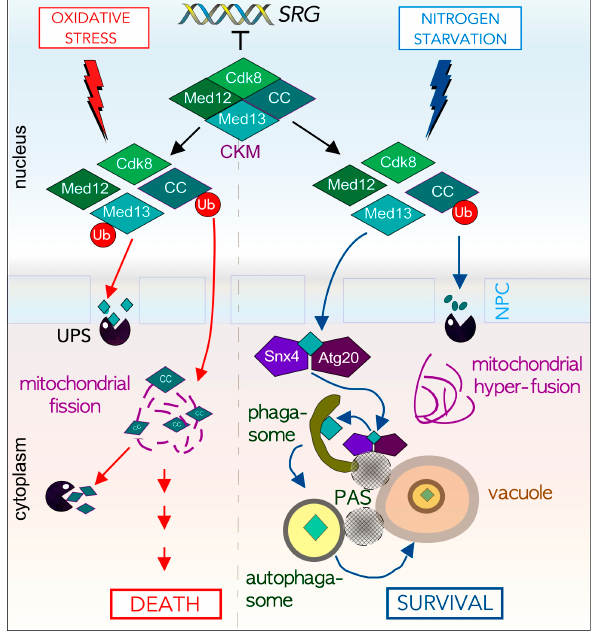
Figure 5. Med13 is destroyed either by the UPS or Snx4-Atg20 mediated autophagic degradation following cell death (left) or survival signals (right). Cartoon outlining stress-dependent fates of cyclin C and Med13, two members of the Cdk8 Kinase module (CKM). Here the subcellular address of cyclin C following stress mediates cell fate decisions by affecting mitochondria morphology. See text for details and